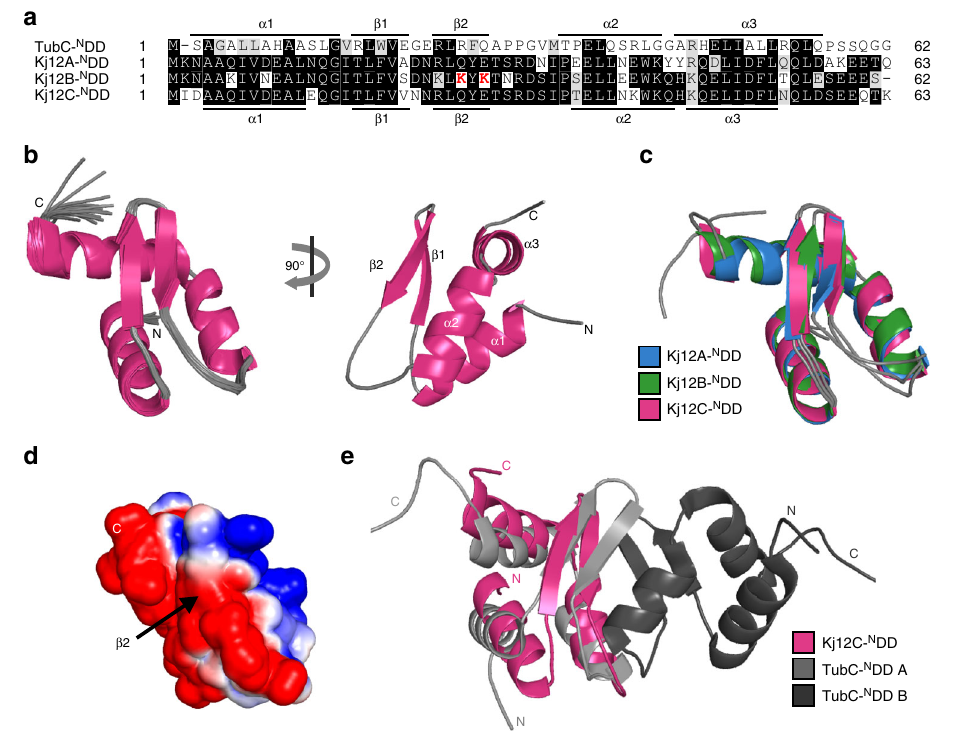
Fig. 2 N-terminal docking domains have the same three-dimensional structure. a Structure-based sequence alignment of the TubC- N DD and the N- terminal docking domains of Kj12ABC. Identical residues are highlighted with dark gray boxes and residues with similar chemical properties are shown in light gray boxes. Key residues for DD interactions are shown in red. The secondary structure based on structural information for TubC- N DD and Kj12C- N DD is indicated above and below the sequence. b Solution structure bundle of the 19 lowest energy conformers and the regularized mean structure for Kj12C- N DD. c Overlay of cartoon representations of the energy minimized mean structures of Kj12A- N DD (blue), Kj12B- N DD (green), and Kj12C- N DD (magenta). d Electrostatic surface potentials of Kj12C- N DD mapped on the solvent-accessible surface in the same orientation as in b (left) with negatively charged surface areas colored in red, positively charged areas coloured in blue, and white areas corresponding to hydrophobic surfaces. e Overlay of the energy-minimized mean structure of Kj12C- N DD with one monomer of the TubC- N DD